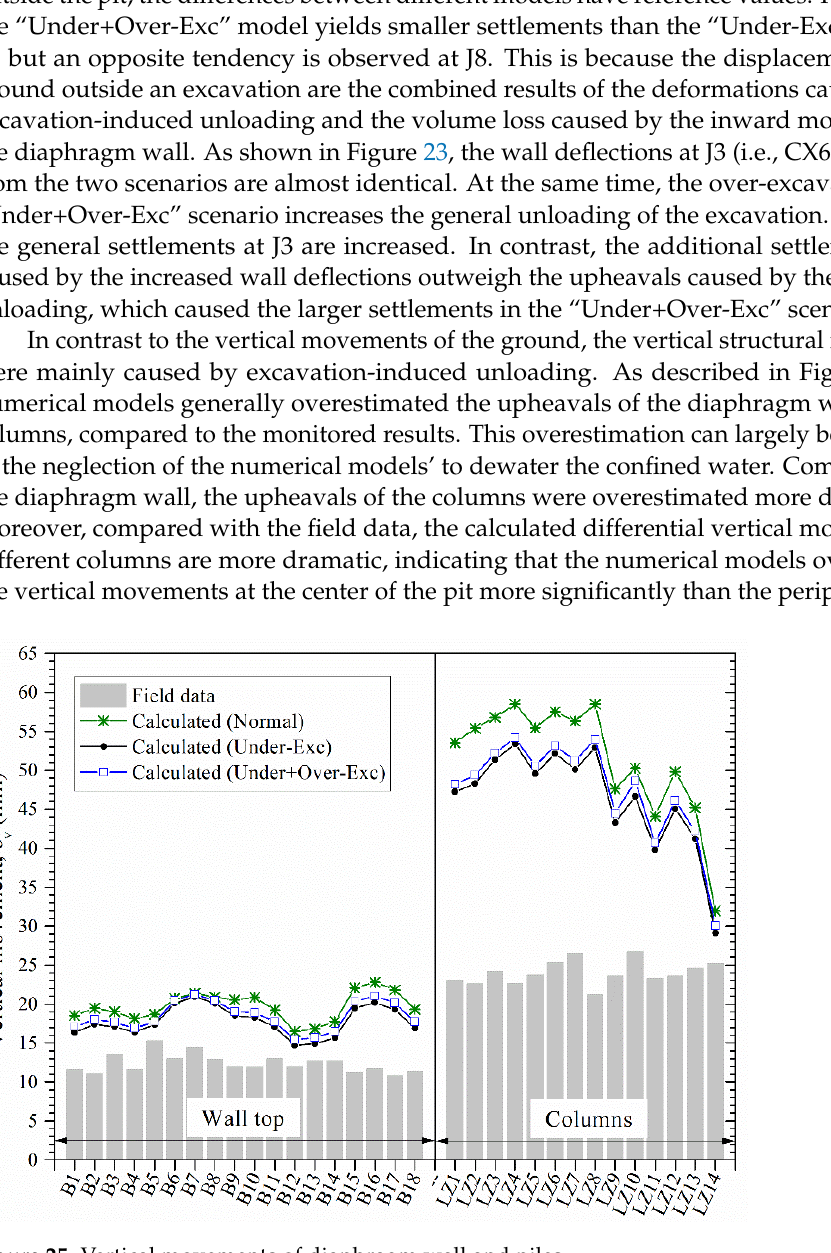
Figure 25. Vertical movements of diaphragm wall and piles.